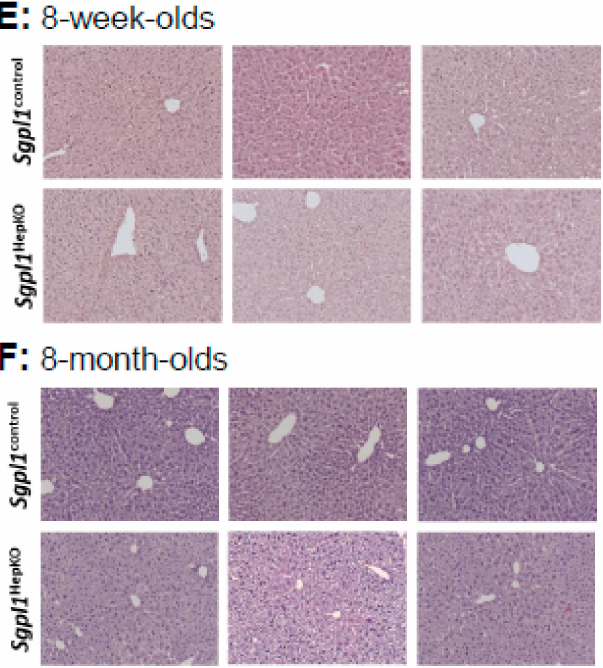
Figure 1. Characteristics of Sgpl1 HepKO mice. Sgpl1 mRNA and SGPL1 protein levels were determined by quantitative real-time PCR and Western blotting, respectively, in liver homogenates of Sgpl1 control and Sgpl1 HepKO mice at the age of 8 weeks ( A ) or 8 months ( B ). The presented Western blots show representative samples from male mice; please note that two different molecular weight markers have been used in A and B. All values are means ± SEM; annotations within the bars indicate the numbers ( n ) of individual mice. * p < 0.05, ** p < 0.01, *** p < 0.001 in nonparametric Mann-Whitney test (mRNA) or two-tailed Student’s t -test (protein). ( C , D ) Liver weight expressed as % of body weight of mice at the age of 8 weeks ( C , n = 19–27) or 8 months ( D , n = 29 and 24). Shown are values of individual mice and their median. ( E , F ) H&E staining of liver slices prepared from Sgpl1 control and Sgpl1 HepKO mice. Shown are representative slices from male mice (3 of each group). M, male mice; F, female